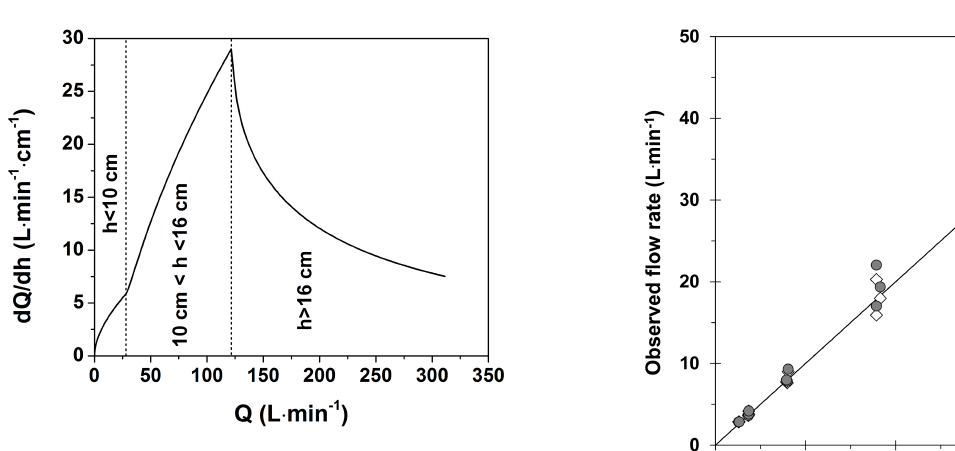
Figure 3. Derivative of the rating curve (d Q /d h ) plotted against the flow rate ( Q) . The curve has inflection points at h = 10cm (when the water reaches the top of the first trapezoid) and at h = 16cm (when the water reaches the top of the slot). Figure 4. Results of the laboratory validation experiment. The un-